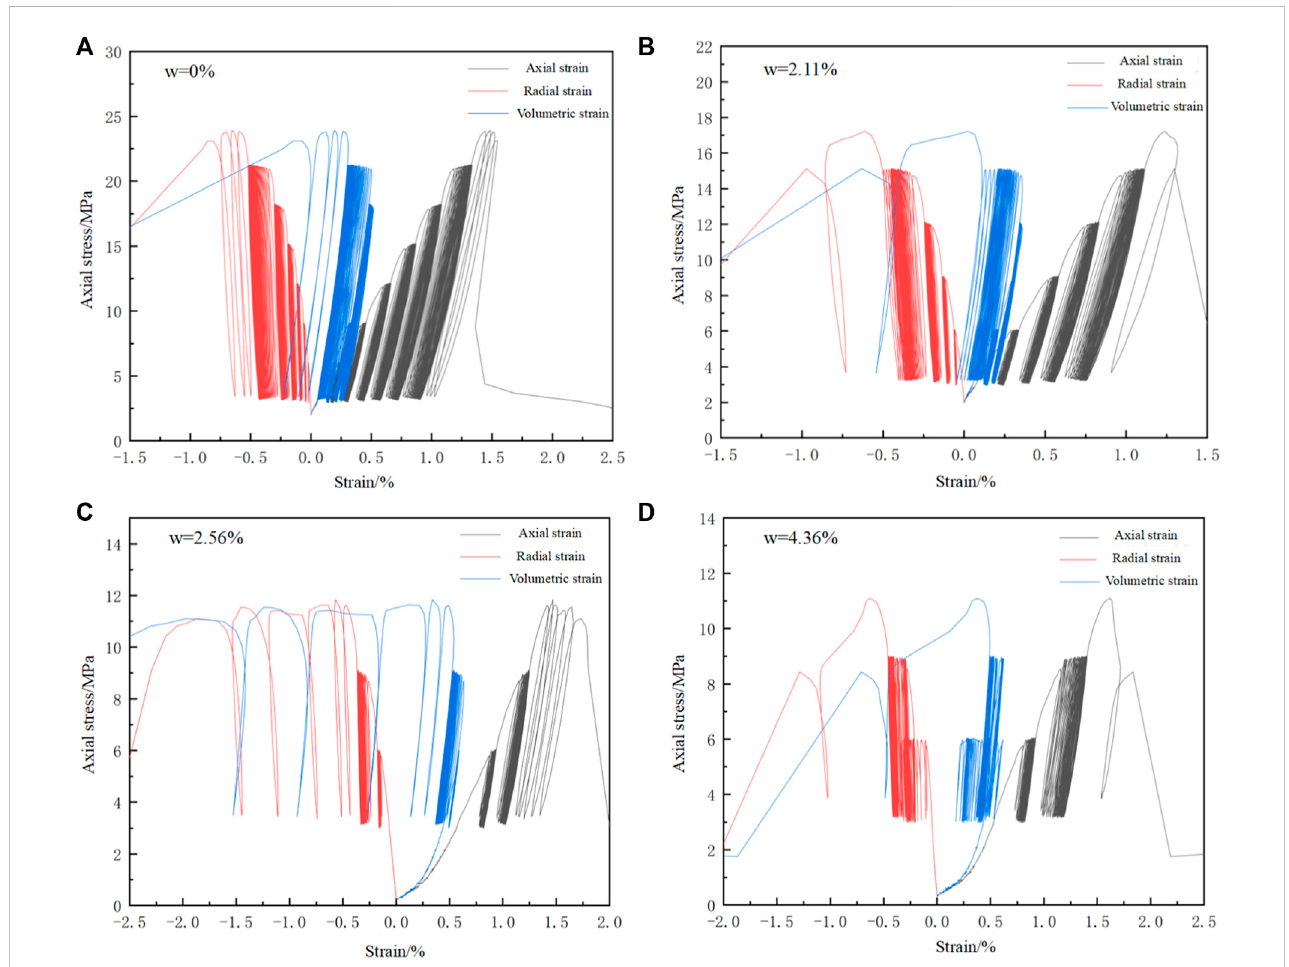
FIGURE 4 Typical axial, radial and volumetric stress strain curves (A-D) The water content is 0%, 2.21%, 2.56%, and 4.36%, respectively).